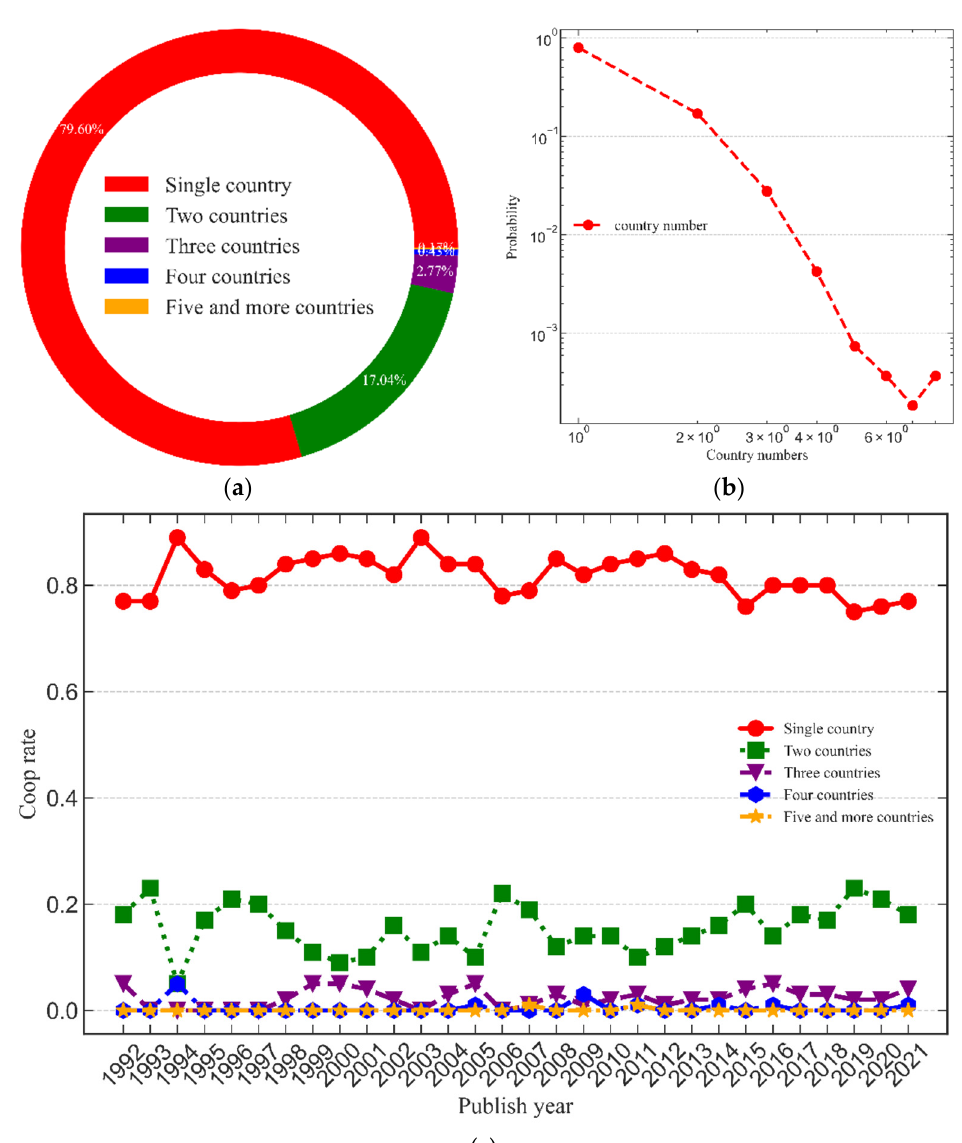
Figure 8. The country collaboration patterns in oil and gas wells. ( a , b ) The publication percentage and probability distribution produced by different country sizes. ( c ) Annual percentage changes in publications produced by different country sizes.